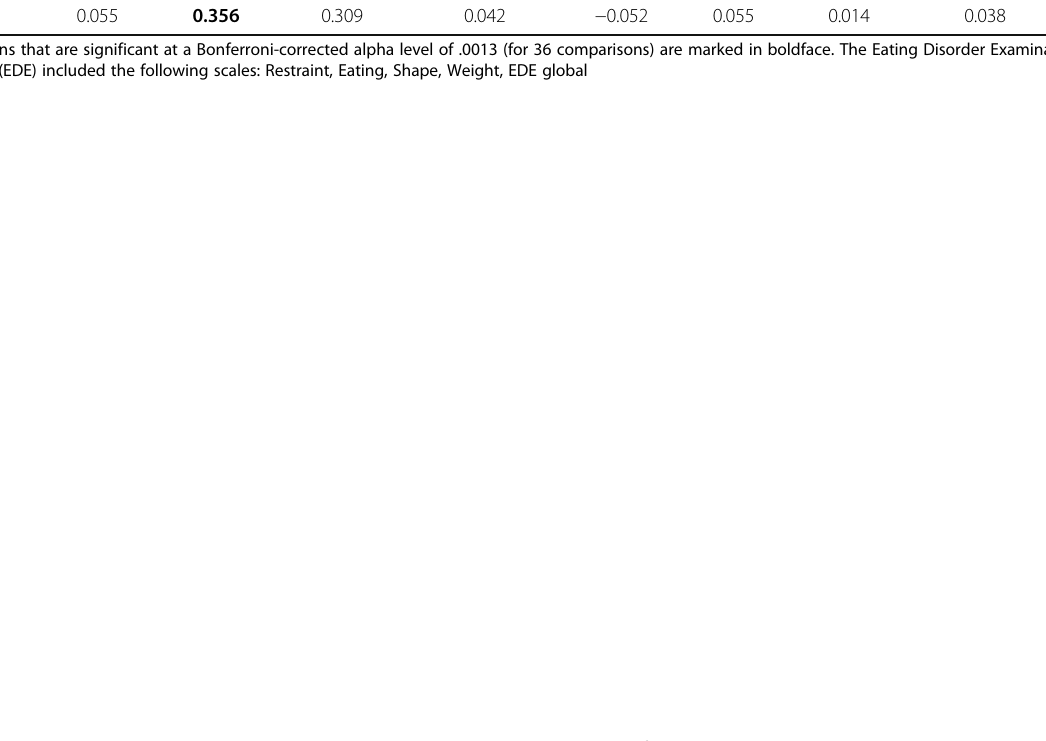
Table 8 Experiment 2: bivariate correlations between person-level covariates of age, education, and Eating Disorder Examination Questionnaire subscales and global scale, as well as correlations with model-derived by-person estimates for response bias